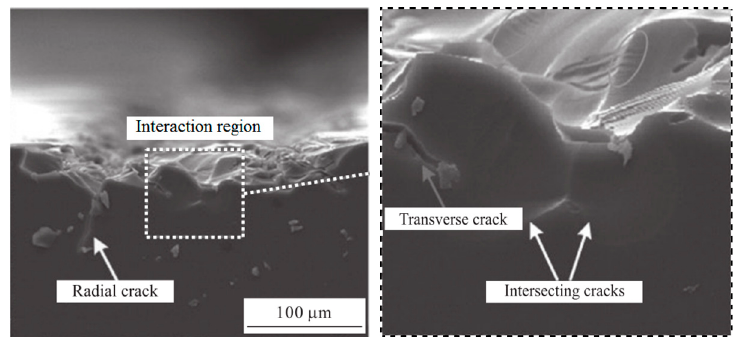
Figure 8. Experimental device (DMG, Germany).